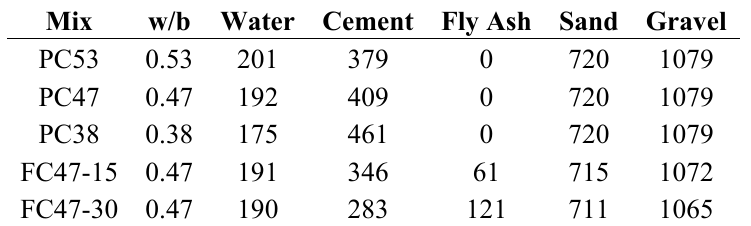
Table 2. Mix proportions of concrete specimens (kg/m 3 fresh